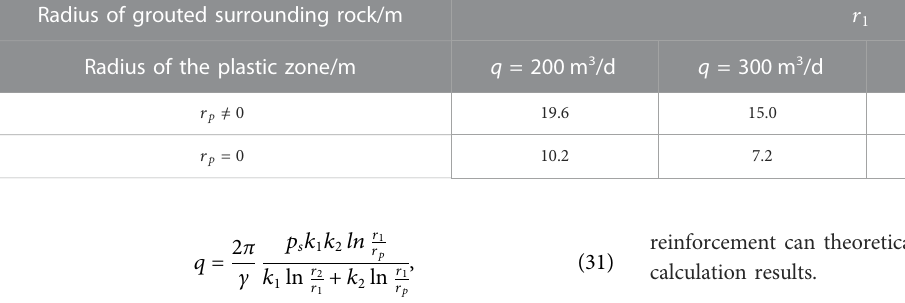
TABLE 1 Relationship between water in fl ow, radius, and plastic zone of grouted surrounding rock. Radius of grouted surrounding rock/m r 1 Radius of the plastic